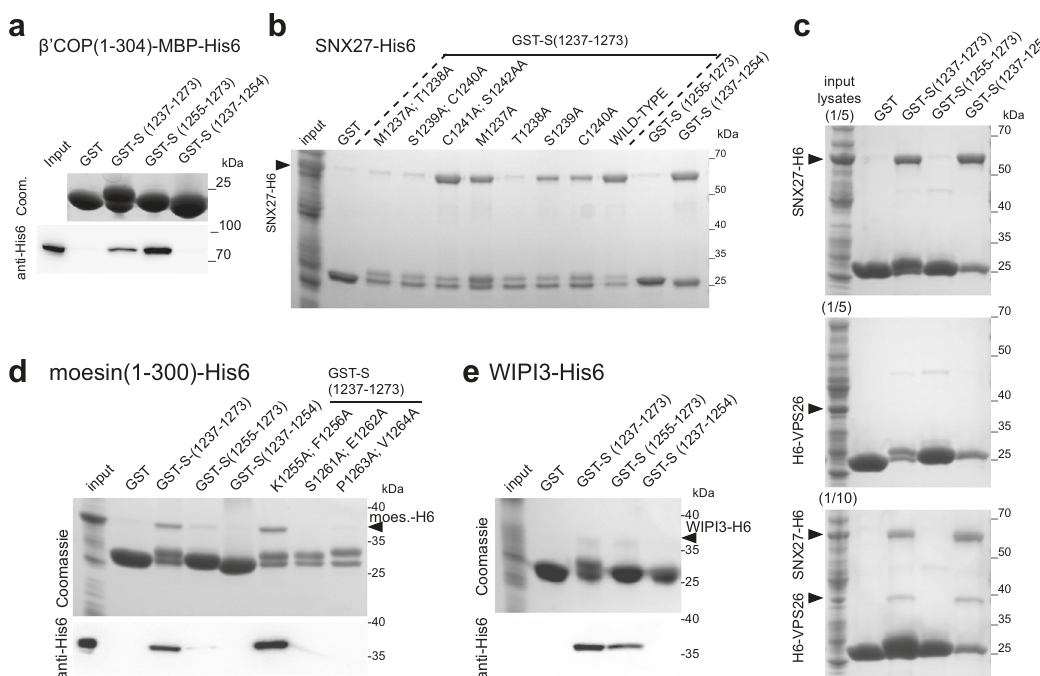
Fig. 2 The tail of SARS-CoV-2 S protein binds directly to moesin, WIPI3, SNX27, and to VPS26 via SNX27. a Coomassie-stained gel and immunoblot against His6 to test the binding from bacterial cell lysates of the β -propellor of the β ’ -COP subunit of COPI (residues 1 – 304 with an MBP-His6 tag) to beads coated with GST fusions to the tail of S. Experiment representative of three repeats with either His6-MBP-tag (as here) or with His6-tag. Input is 1/50 of that applied to beads. b Coomassie gel showing that the residues 1238ThrSerCys1240 of the tail of S are required for binding to SNX27. As in ( a ) except that the lysate was from cells overexpressing SNX27-His6. The experiment repeated three times, input 1/40 that applied to beads. c Coomassie gel showing that VPS26 requires SNX27 to bind to the tail of S protein. Same experiment as in ( a ) except that beads coated with the GST-fusions were incubated with bacterial lysate from cells overexpressing either SNX27-His6, His6-VPS26 or both. The experiment repeated twice. d Coomassie-stained gel and immunoblot against His6 to test the binding of the FERM domain of moesin (residues 1 – 300, expressed in bacterial lysate) to GST fusions to the tail of S. Experiment repeated twice, input is 1/40 (Coomassie) or 1/160 (immunoblot) of that applied to beads. e As in ( d ), except beads coated with the indicated GST-fusions were incubated with lysates from bacteria overexpressing WIPI3-His6. The experiment repeated twice, input is 1/14 (Coomassie) or 1/160 (immunoblot) of that applied to